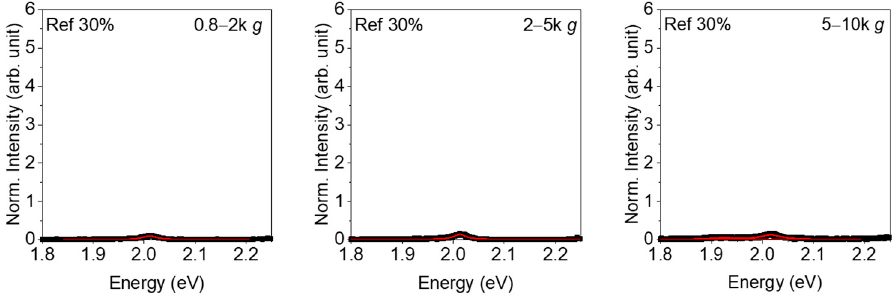
Figure A5. Photoluminescence spectra ( λ exc = 532 nm) of the reference WS 2 nanosheet dispersions, exfoliated by tip sonication with a 30% amplitude. The PL was fitted by Lorentzians for quantitative analysis. Spectra of fractions which were collected during liquid cascade centrifugation but did not show any PL are excluded.